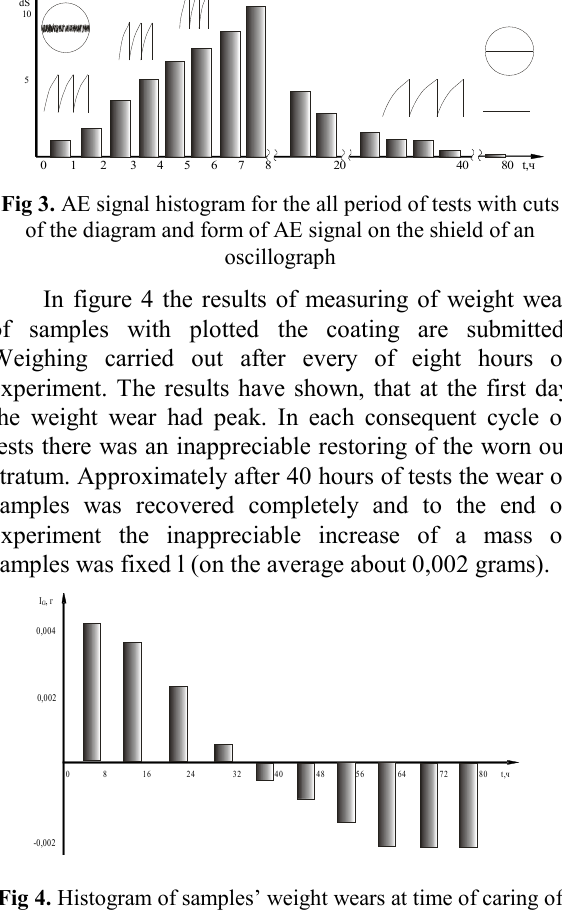
Fig 4. Histogram of samples’ weight wears at time of caring of coating